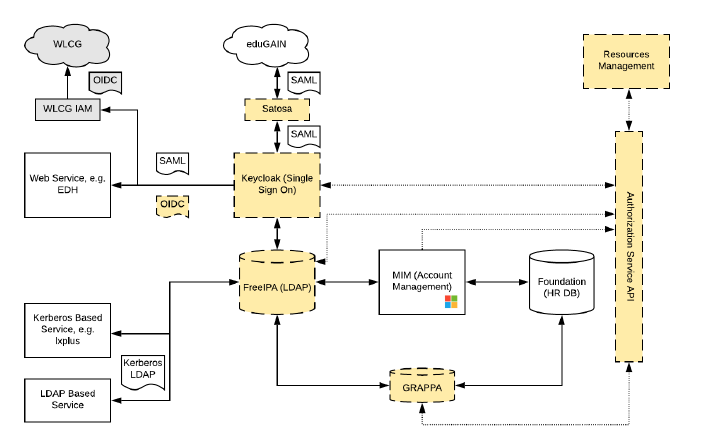
Figure 3. Future architecture, including many open source components. Administration portals and minor services are excluded for simplicity. Yellow boxes with dashed edges in Figure 3 represent components that have been added, replaced or changed significantly, and are explained in more detail below. Grey boxes represent the integration of WLCG services behind the new CERN